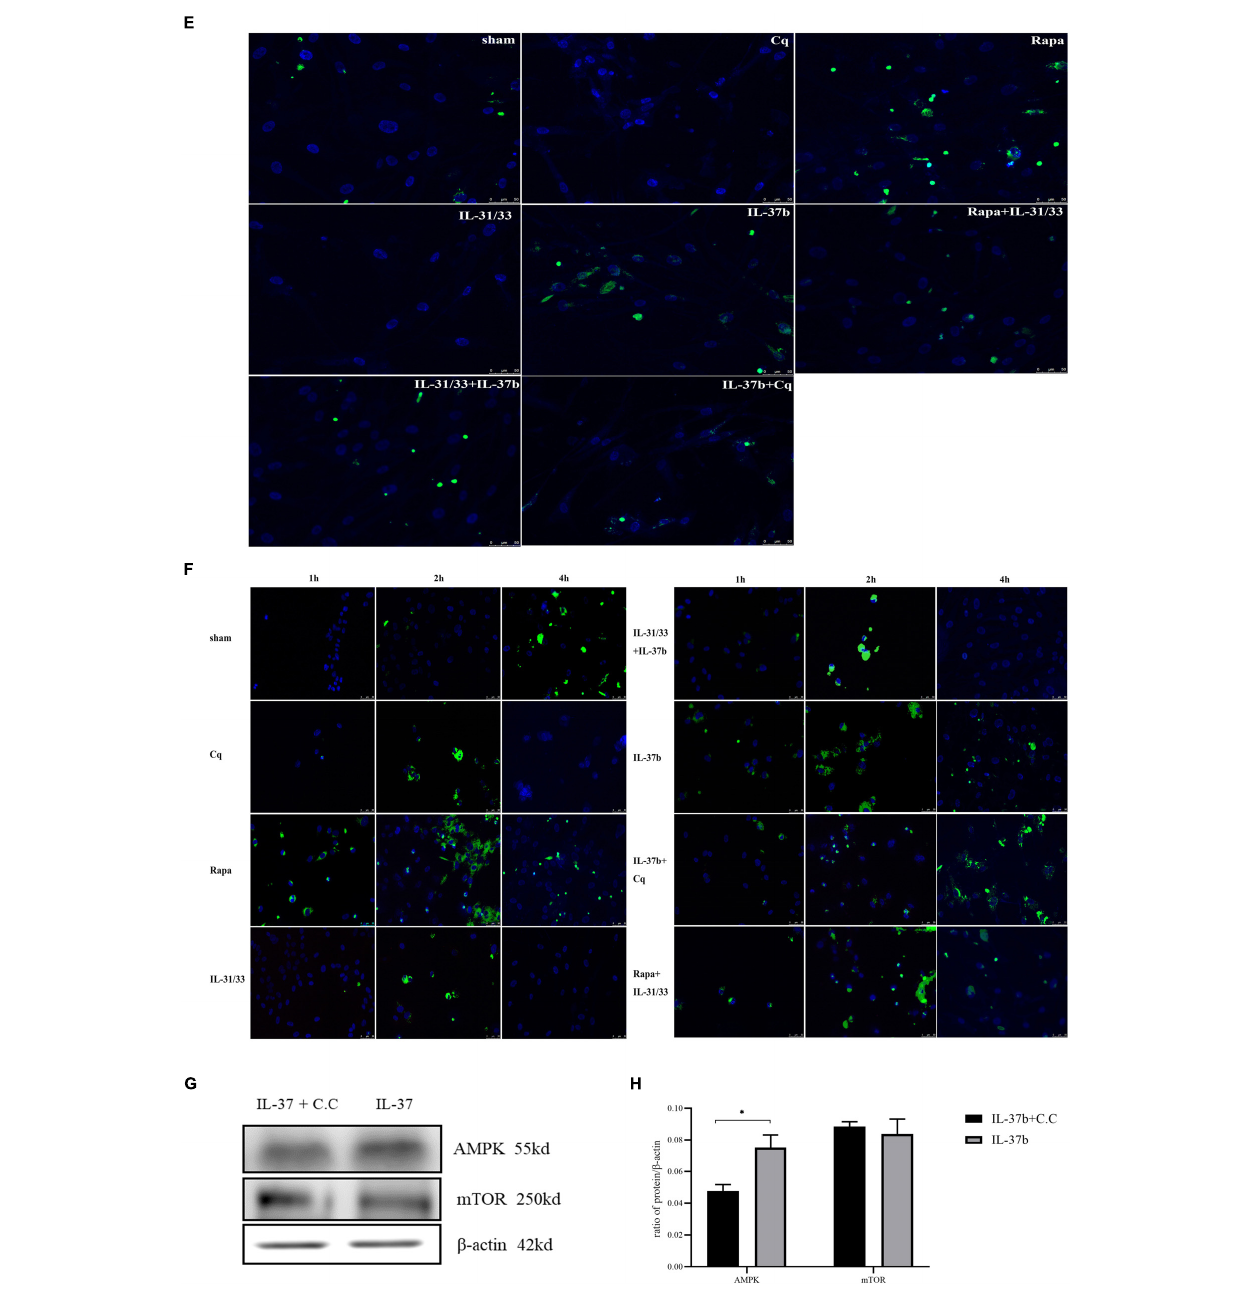
FIGURE 1 | Effect of IL-37b on the induction of autophagy by analyzing the expression of p62, LC3B, AMPK and mTOR in human eosinophil-dermal fibroblast co-culture upon IL-31 (100 ng/mL) and IL-33 (100 ng/mL) stimulation. Cq: chloroquine (20 µ M), autophagy negative control. Rapa: rapamycin (10 ng/mL), autophagy positive control. To verify the up-regulatory effect of IL-37b on AMPK, dorsomorphin (20 µ M, Compound C/C.C), an AMPK inhibitor, together with IL-37b were applied in the co-culture. (A) Western blots analysis and (B) Quantification of AMPK, mTOR, p62 levels normalized to β -actin and LC3II/LC3I ratio (100 ng/mL IL-37b treatment for 24 h). (C) Western blot analysis. The Cq band for β -actin has been spliced from the same gel, due to an experimental error. Please see the Supplementary Material for the original blot image. (D) Quantification of AMPK, mTOR, p62 levels normalized to β -actin and LC3II/LC3I ratio in co-culture treated with IL-31, IL-33, and IL-37b (100 ng/mL), chloroquine and rapamycin treatment for 16 h. (E) Representative images of LC3 puncta (green) in co-culture treated with IL-31, IL-33, and IL-37b (100 ng/mL), chloroquine and rapamycin treatment for 16 h. (F) Representative images of LC3 puncta (green) in co-culture treated with IL-31, IL-33, and IL-37b (100 ng/mL), chloroquine and rapamycin treatment for 1, 2, and 4 h. Nuclei were visualized by DAPI (blue) staining. (G) Western blot analysis. (H) Quantification of AMPK and mTOR levels normalized to β -actin in co-culture treated with Compound C and IL-37b for 16 h. Chloroquine (Cq) pretreatment for 60 m prior to IL-37b treatment; rapamycin (Rapa) pretreatment for 10 m prior to IL-31 and IL-33 treatment. Bar charts are shown as mean ± SEM of triplicate independent experiments. * P < 0.05, ** P < 0.01, and *** P < 0.001 when compared between the denoted groups.